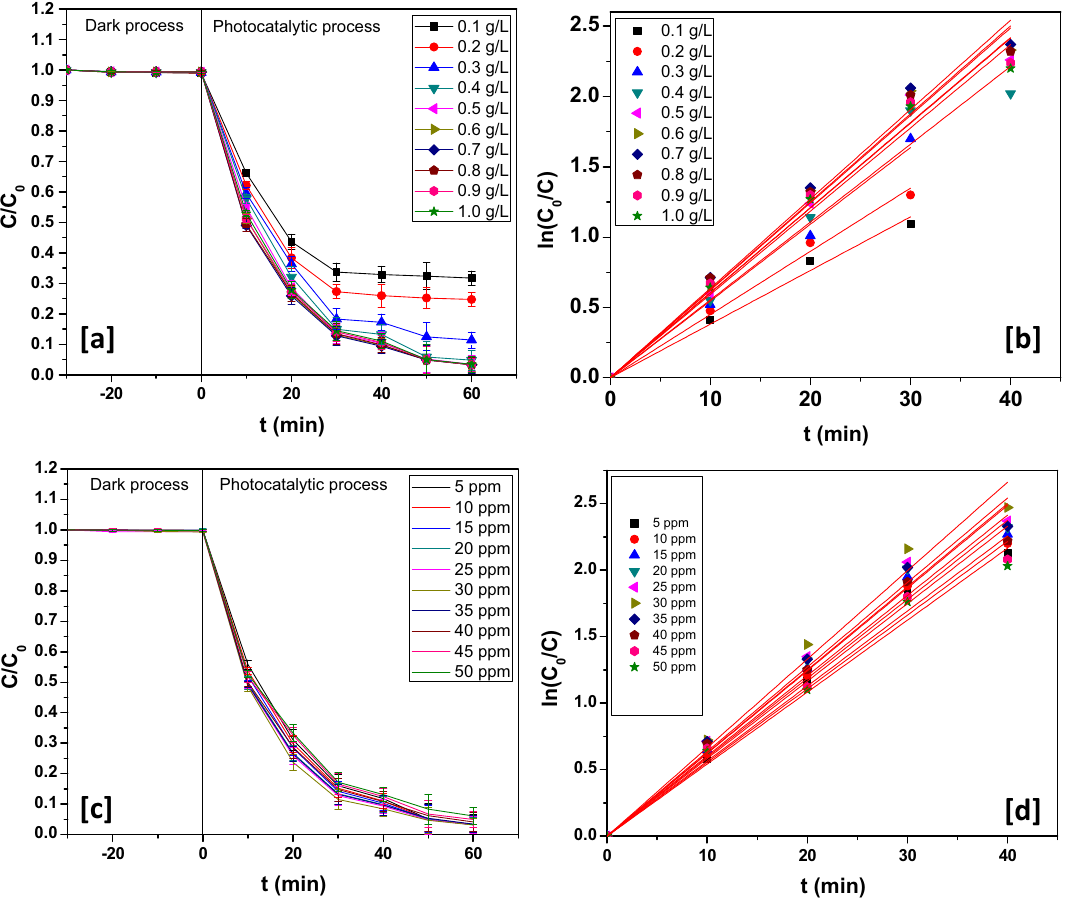
Figure 6. ( a ) Dynamics and ( b ) kinetics profile at different catalyst loading. ( c ) Dynamics and ( d ) kinetics profile at different rabeprazole concentration